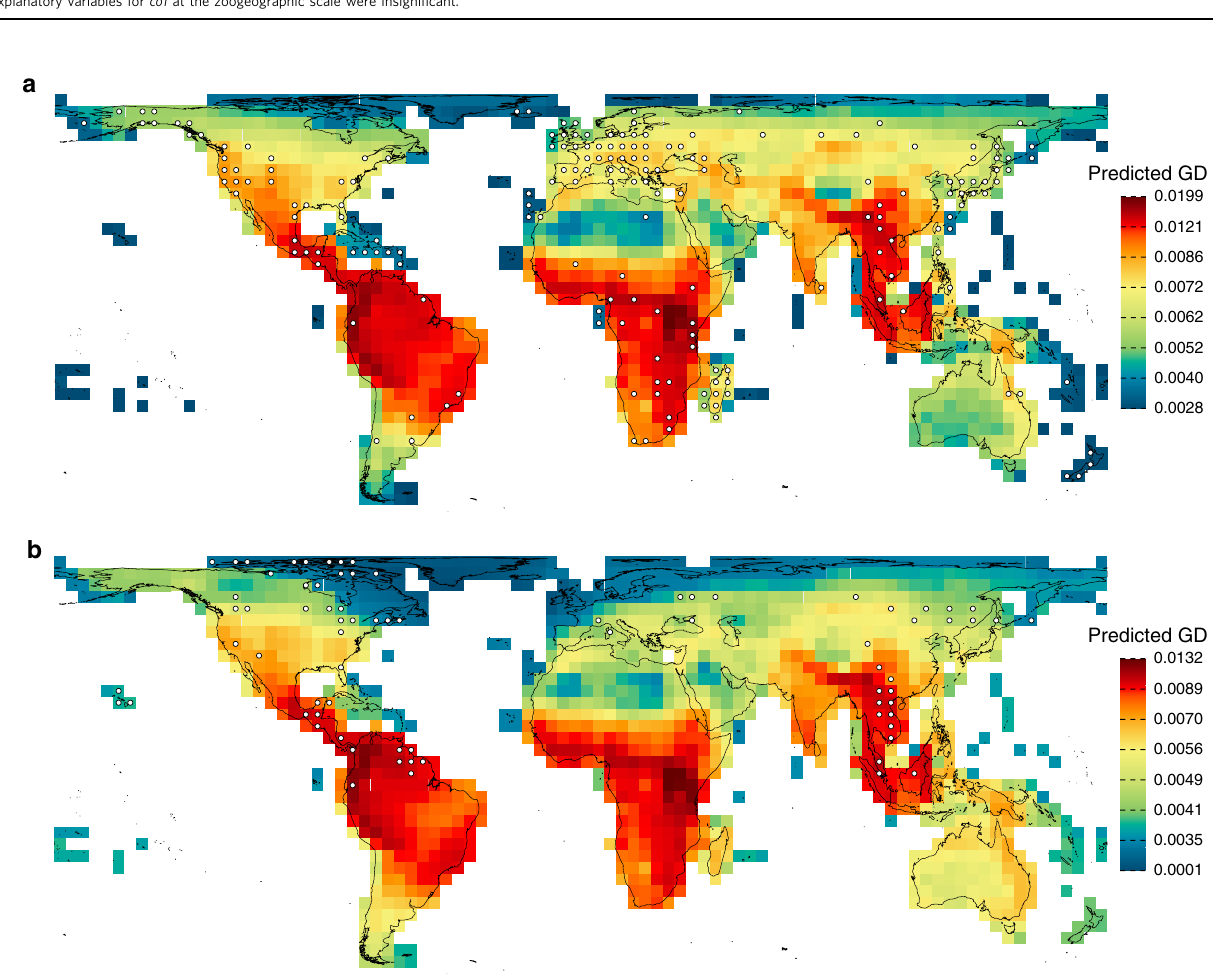
Fig. 3 Predicted genetic diversity for two mitochondrial genetic markers. Predicted genetic diversity based on the most parsimonious model identi fi ed using multimodel inference (see Tables 1 and 2). For cytb ( a ), the most parsimonious model included only PD (see also Fig. 2a), while for co1 ( b ) the most parsimonious model had phylogenetic diversity and temperature trend as explanatory variables. White dots indicate the retained grid cells ( n = 185 for cytb and n = 76 for co1 at 7% minimum taxonomic coverage) used to build the